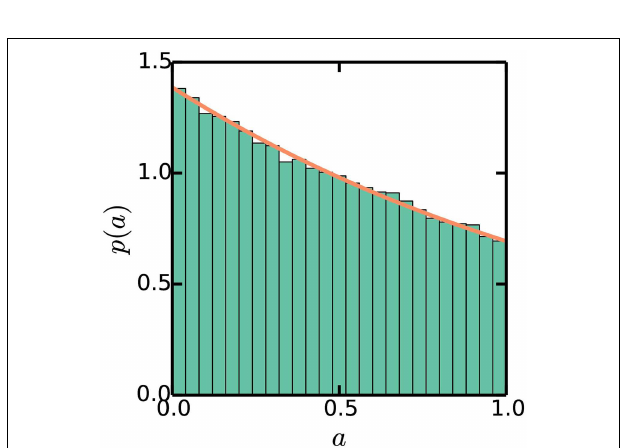
FIGURE 4 | Stationary exponential distribution of cell ages. Simulations are the same as Figure 3 . The line plots p ( a ) = ( ln 2 ) 2 1 − a , as described in the